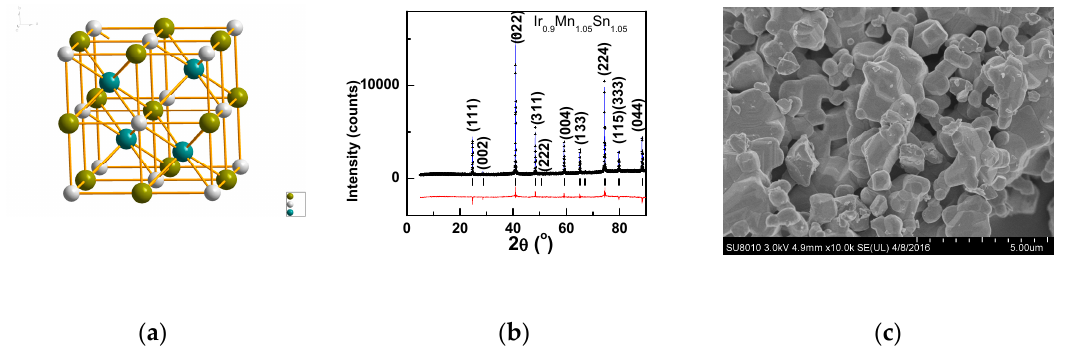
Figure 1. ( a ) The unit cell of the half-Heusler alloy; ( b ) the XRD pattern of Ir 0.9 Mn 1.05 Sn 1.05 with the black cross as the experimental data, the blue line as the fitted pattern, the red pattern at the bottom as the difference between the experimental and the calculated pattern, and the black ticks in the middle as the Bragg positions; and ( c ) SEM image of Ir 0.9 Mn 1.05 Sn 1.05 .